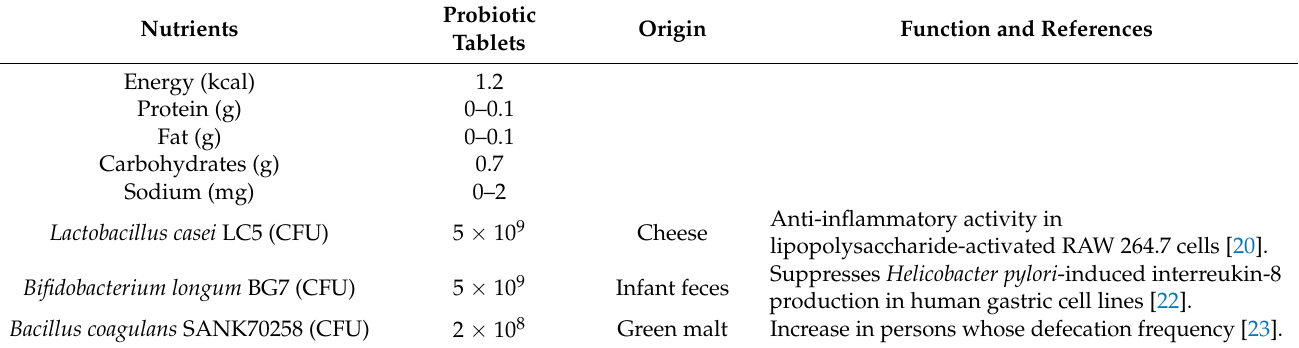
Table 1. Composition of probiotic